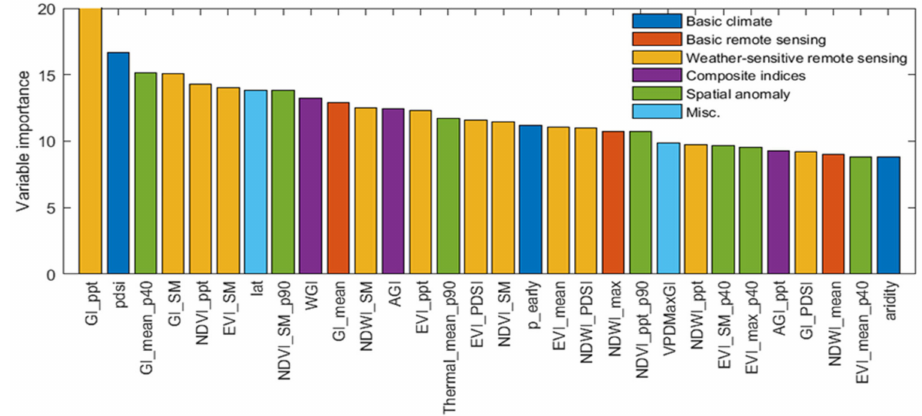
Figure 6. Top 30 (of 98) important variables as identified by RF; variables are grouped into six categories as indicated by different colors (Sections 2.2 and 2.3, Tables 1 and 2, Table S2, Supplementary